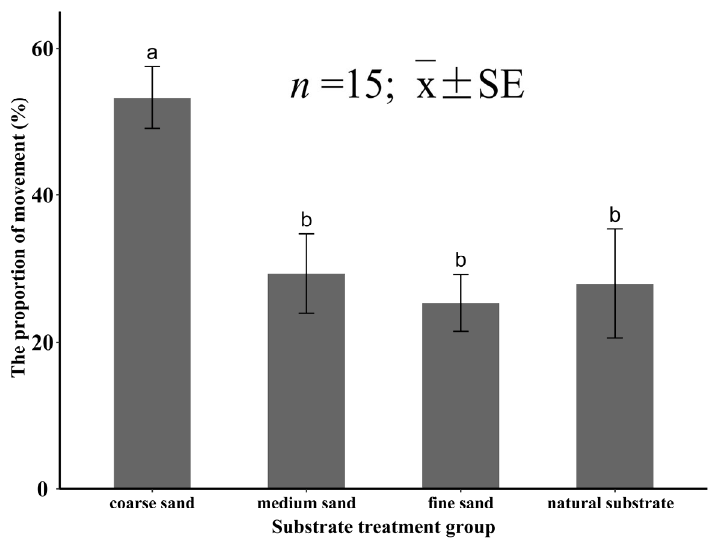
Figure 11. The percentage of juvenile Meretrix meretrix movement in the different grain size substrates. The different letters above the bar graphs indicate significant differences ( p < 0.05).